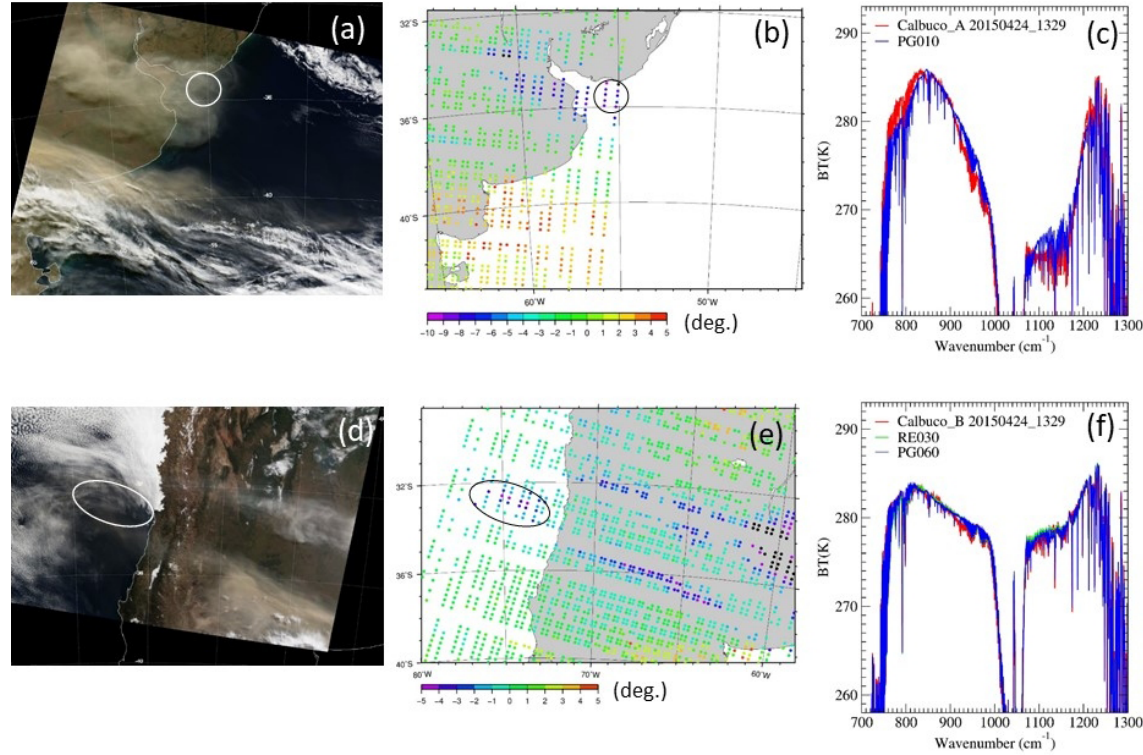
Figure 13. Brightness temperature difference (cid:49) BT split of Calbuco ash plumes measured by IASI at 13:29UTC on 24 April 2015 over the Atlantic Ocean (Calbuco_A, b ), and the measured (red) and calculated (PG010, blue) BTS for the pixel at (lat, long) = (35.265 ◦ S, 55.656 ◦ W) (c) . MODIS visible-color image of the same region at 13:25UTC (a) . (d–f) The same as (a–c) but for ash plumes over the Pacific Ocean (Calbuco_B, marked with a circle in e ) and the measured BTS at (lat, long) = (32.592 ◦ S, 75.050 ◦ W). Calculated BTS without SO 2 gas from the RE030 (green line) and PG060 (blue line) RI models are also shown. The measurement time of the MODIS color image (d) was